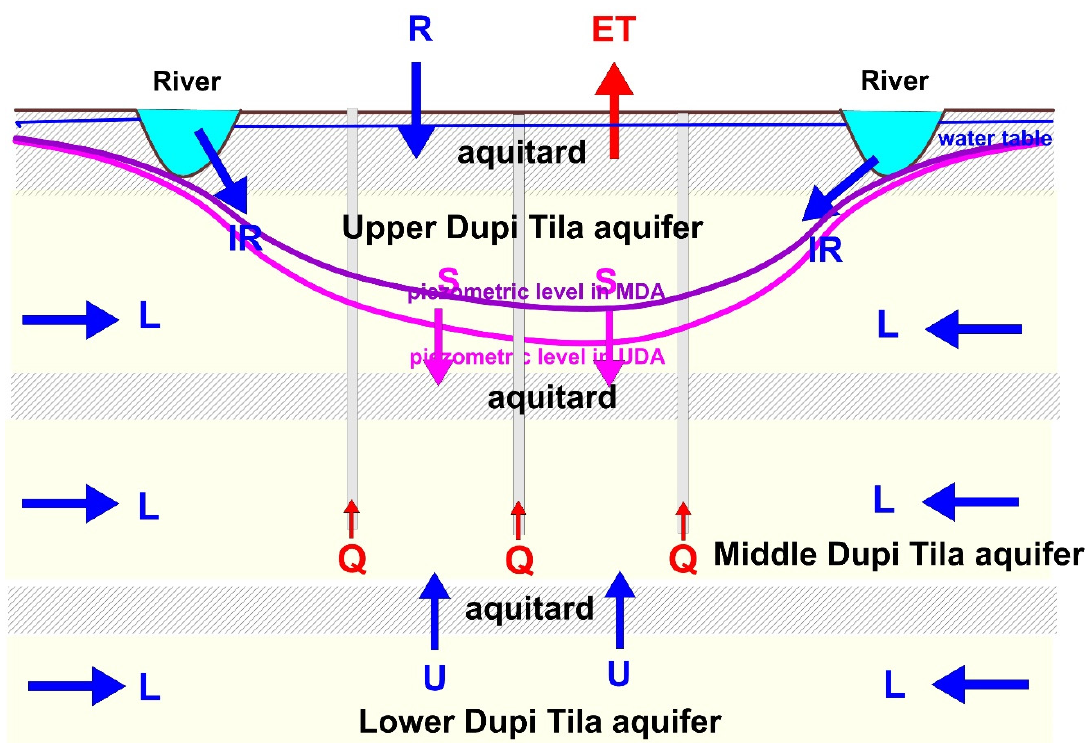
Figure 17. Water balance components of the groundwater reservoir in Dhaka city. R = Recharge (vertical), ET = Evapotranspiration, IR = Irrigating, L = Lateral inflow, U = Upward flow, Q = Pumping, S = Storage.